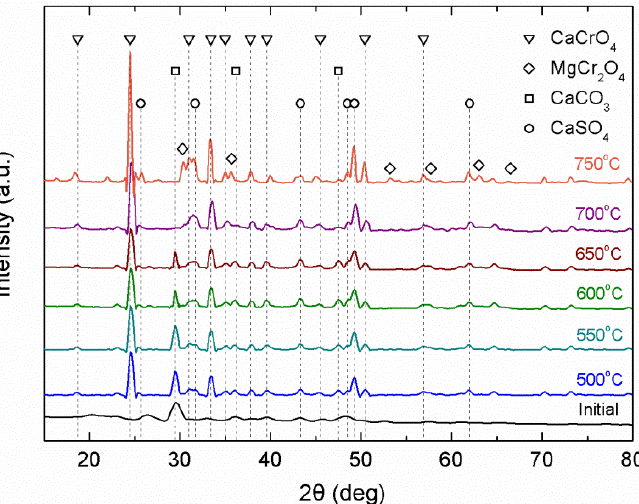
Figure 2. X-ray diffraction (XRD) diagrams of raw tannery sludge and the corresponding ashes after the application of thermal treatment.